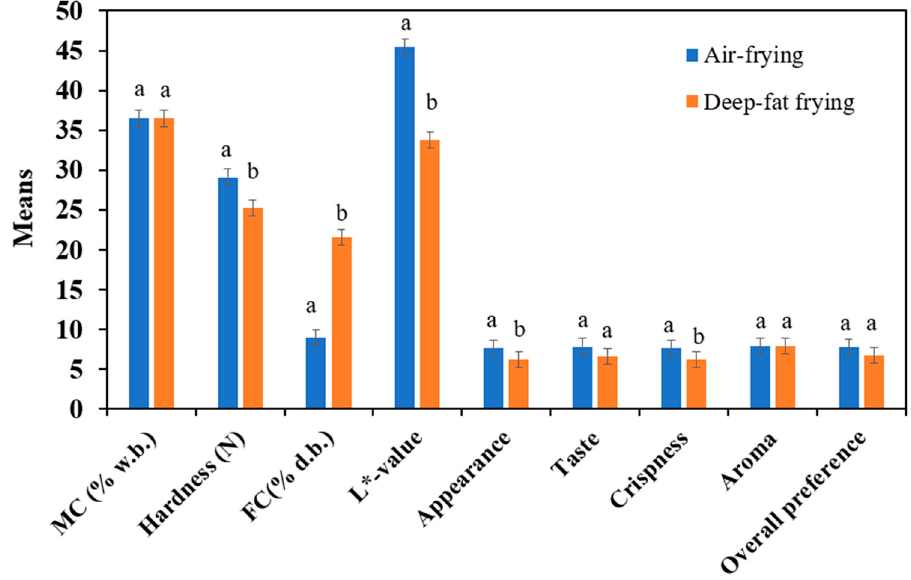
Figure 5. Comparison among different attributes of optimal hot air and deep fat-fried falafel obtained. Different letters indicate the significant difference. While similar letters indicate non-significant difference.